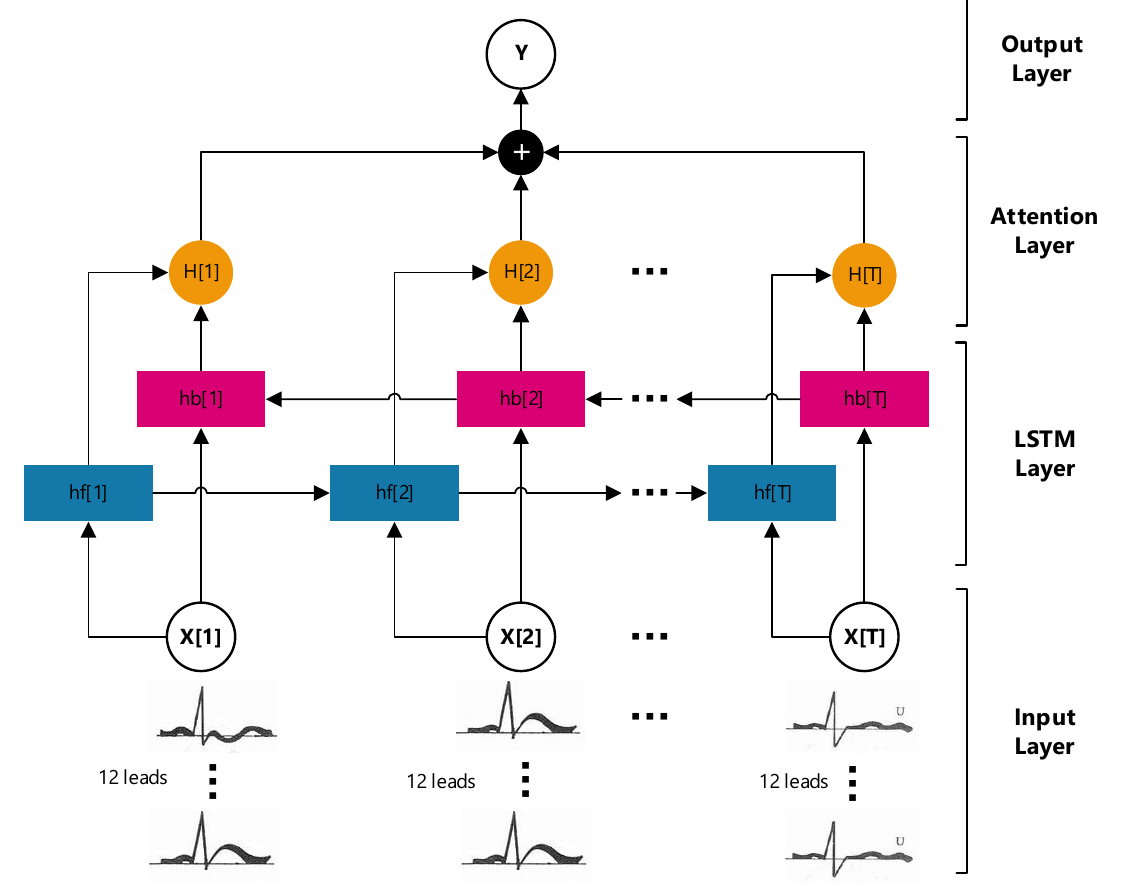
Figure 4. Model Figure 4. Model Framework.